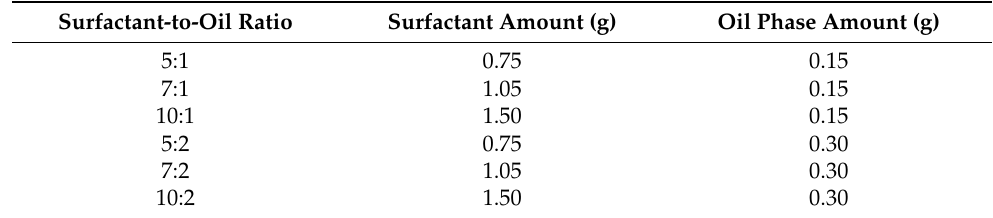
Table 3. Concentrations of surfactant and lipids used in the preparation of lidocaine nanoemulsions. Surfactant-to-Oil